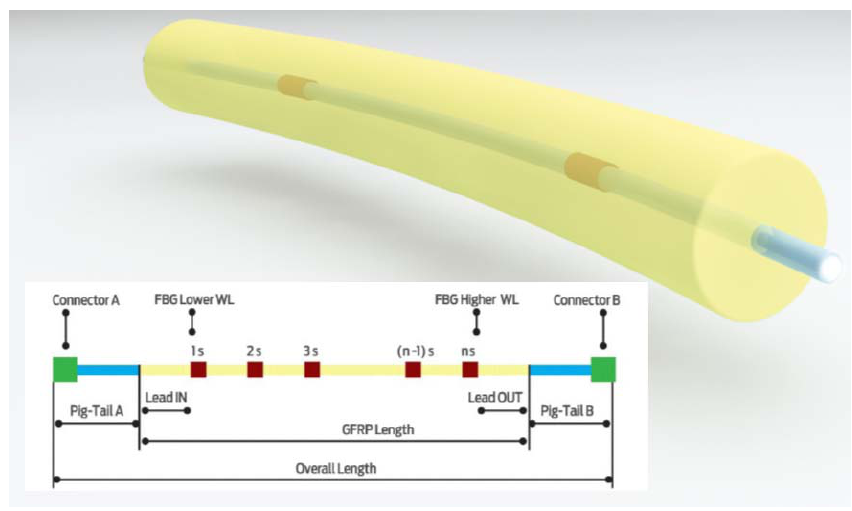
Figure 1. Fiber Bragg grating (FBG) configuration with Draw Tower Gratings (DTG ® ) [15].